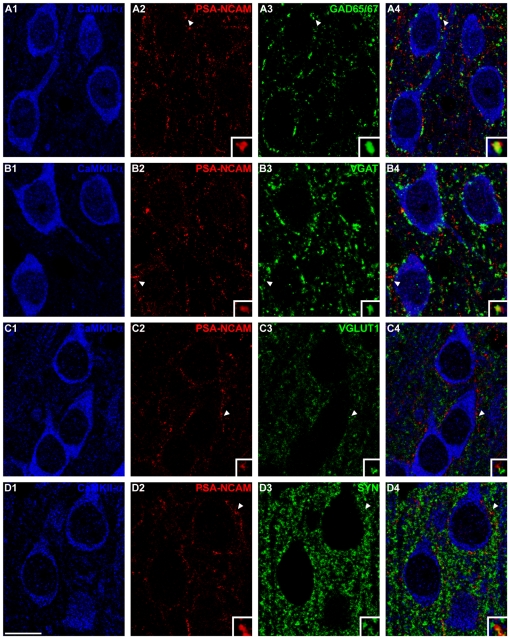
Confocal microscopic analysis of the neurochemical phenotype of PSA-NCAM immunoreactive puncta surrounding pyramidal cell somata in mPFC.(A) PSA-NCAM-expressing puncta co-localizing with GAD67 in the perisomatic region of CaMKII-α expressing neurons. (B) PSA-NCAM/VGAT double-labeled puncta surrounding CaMKII-α immunoreactive neurons. (C) Lack of co-localization between perisomatic PSA-NCAM-expressing puncta and VGLUT1-expressing puncta. (D) Perisomatic puncta co-expressing PSA-NCAM and SYN. All the images in this figure are taken from single confocal planes. Scale bar: 10 µm. Insets in the images are 5× enlargements of puncta marked with arroheads.